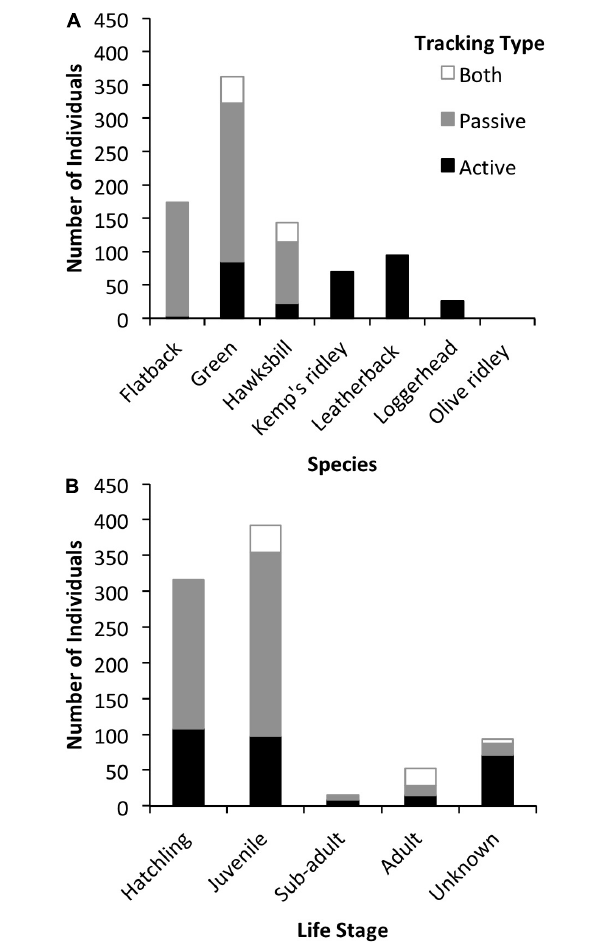
FIGURE 4 | (A) Number of individuals per species tracked with active tracking (black), passive tracking (gray), or both types of tracking (white). (B) Number of individuals per life stage tracked actively (black), passively (gray), or with both tracking types (white).